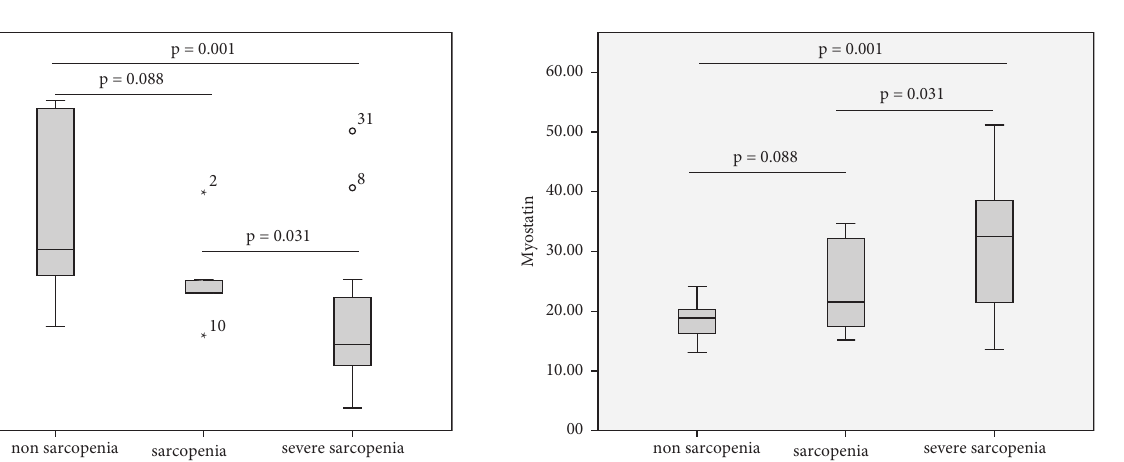
Figure 1: Comparisons of IGF-1 levels in sarcopenia status group. Figure 2: Comparisons of myostatin levels in sarcopenia status